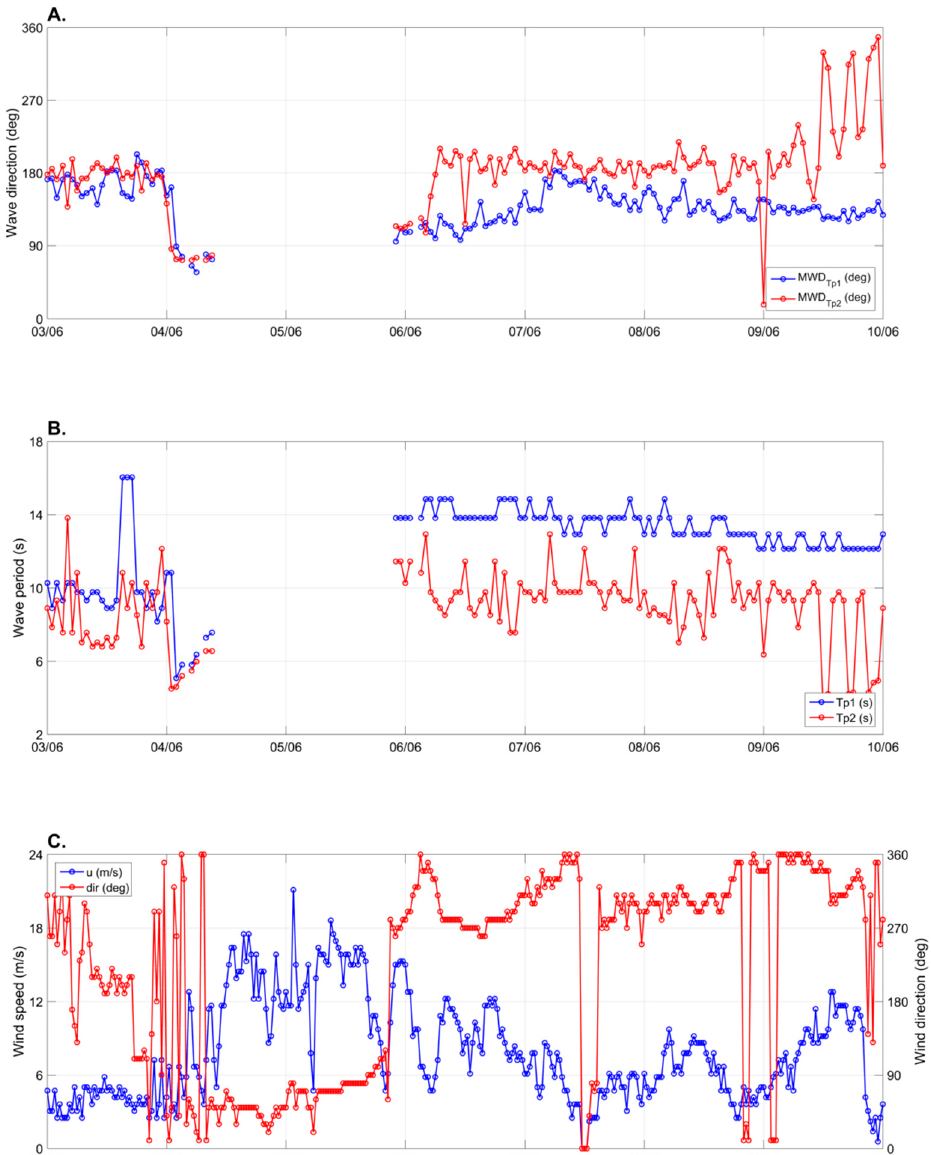
Figure A1. Observations of ( A ) mean wave direction at the first and second spectral peaks ( MWD Tp1 and MWD Tp2 ); ( B ) wave period at the first and second spectral peaks ( Tp 1 and Tp 2 ); and ( C ) wind speed ( u ) and direction ( dir ) from 3 to 10 June 2016. Wave data was recorded at the Sydney waverider buoy and wind data was recorded at the Kurnell Automatic Weather Station (locations Figure 3).